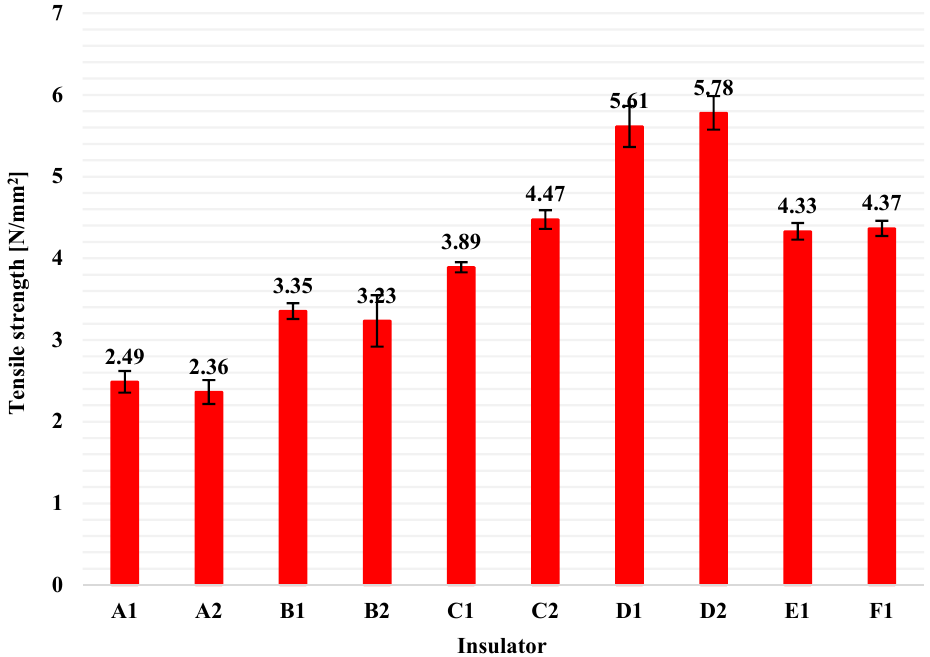
Figure 7. Tensile strength average values (columns) and the corresponding standard deviations (error bars) for the HTV silicone rubber with ATH filler material of all available composite insulators.